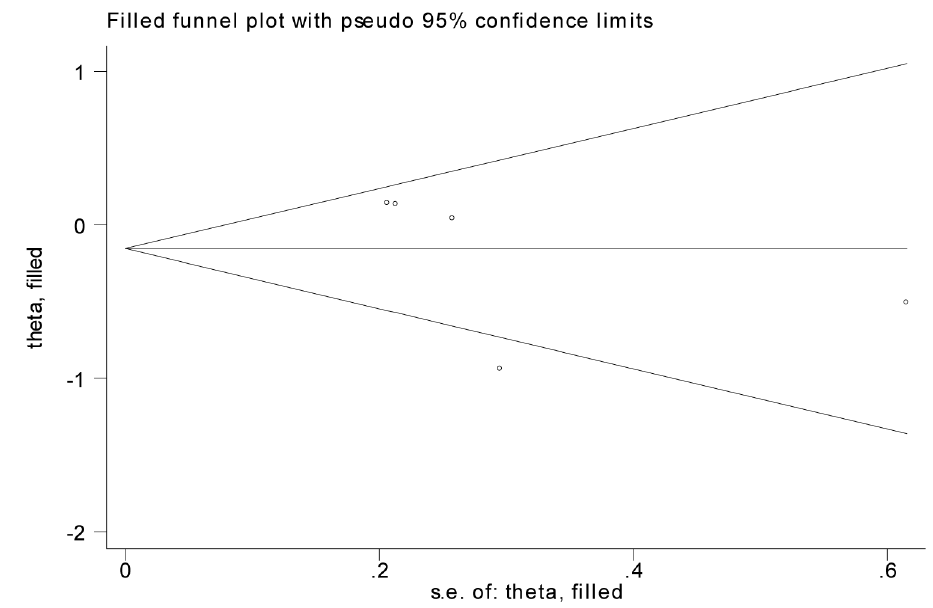
Figure 6. Funnel plot of 5-year DFS survival rate after fill-and trim method.